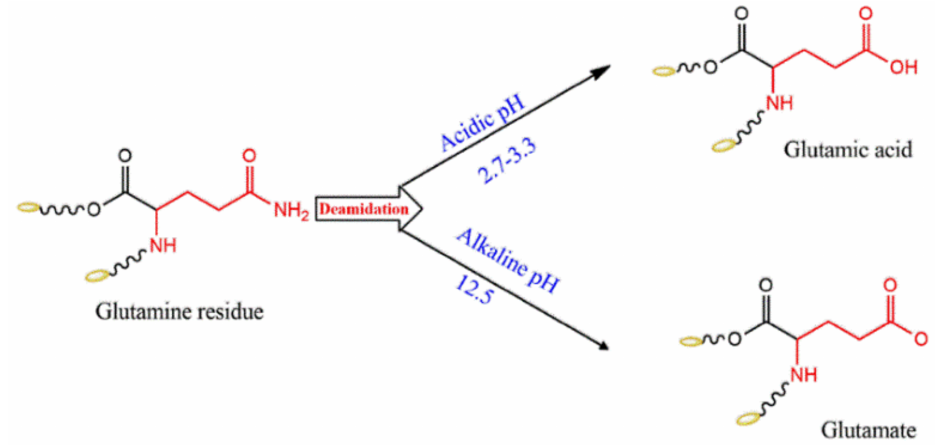
Figure 3. Possible deamidation products of zein at acidic and basic